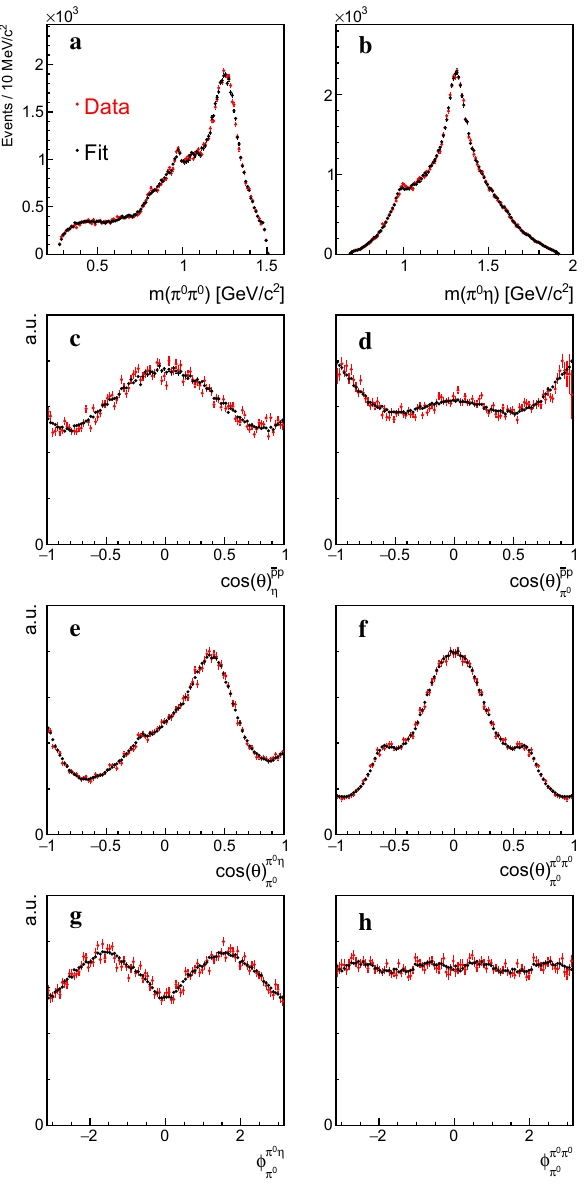
Fig. 7 Not acceptance corrected invariant π 0 π 0 and π 0 η mass distri- butions ( a , b ), acceptance corrected decay angular distributions for the production ( c , d ) and for the decay ( e – h ) of the reaction ¯ pp → π 0 π 0 η . The data are marked with red and the fit result is illustrated by black dots with error bars the best fit to the data (called reference fit), Monte Carlo samples for the individual channels have been